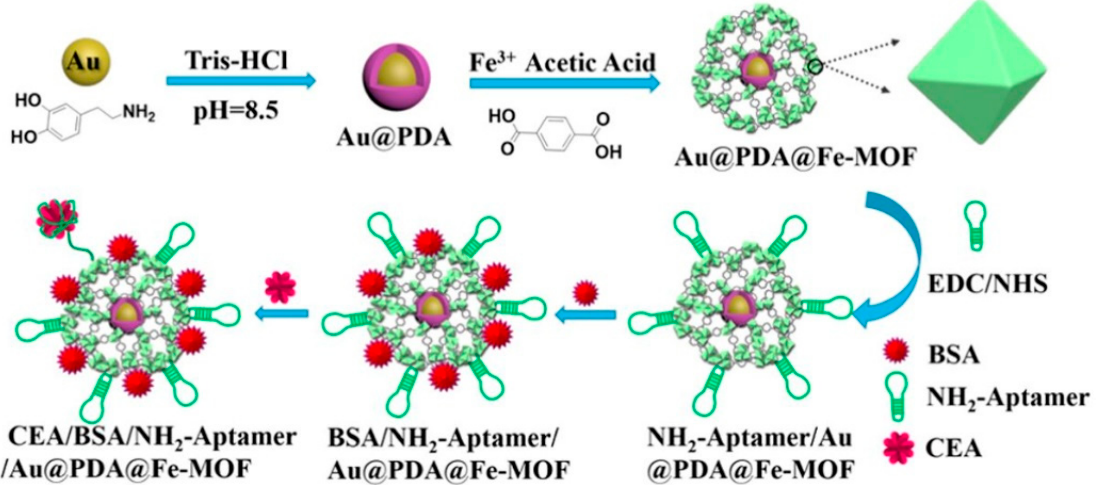
Figure 4. Electrochemical aptasensor for carcinoembryonic antigen in serum. A glassy carbon electrode is coated with AuNPs where Fe-MOFs and polydopamine are formed. NH 2 -aptamers for the carcinoembryonic antigen can be attached and the resulting coated AuNPs are used to detect carci- noembryonic antigen molecules. Image adapted from [39] with permission of American Chemical Society, 2020.